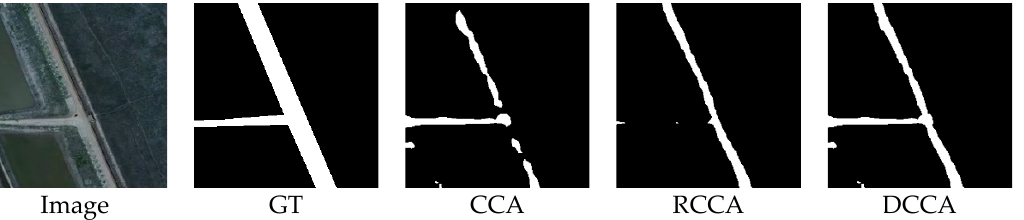
Figure 26. The image, ground truth and the output compilation.